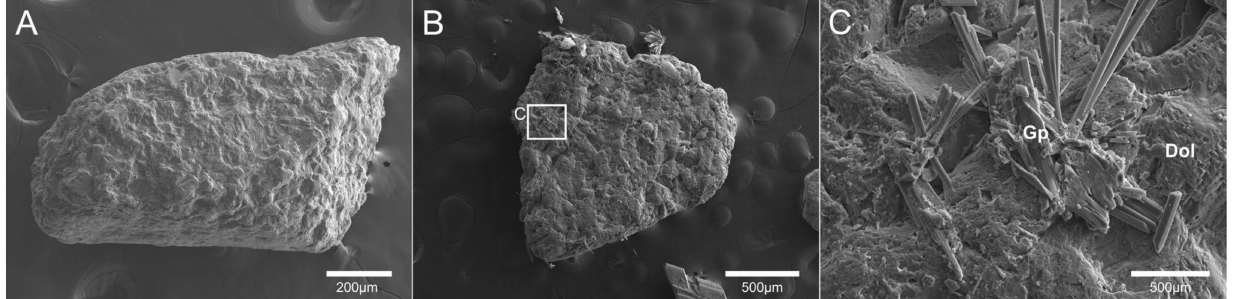
Figure 6. SEM images of dolomite crystals from ( A ) the background site and ( B ) ARAON Mound. ( C ) Enlarged SEM image of the marked C and white square in ( B ). Note the gypsum overgrowth on the surface of the dolomite. Dol: dolomite, Gp: